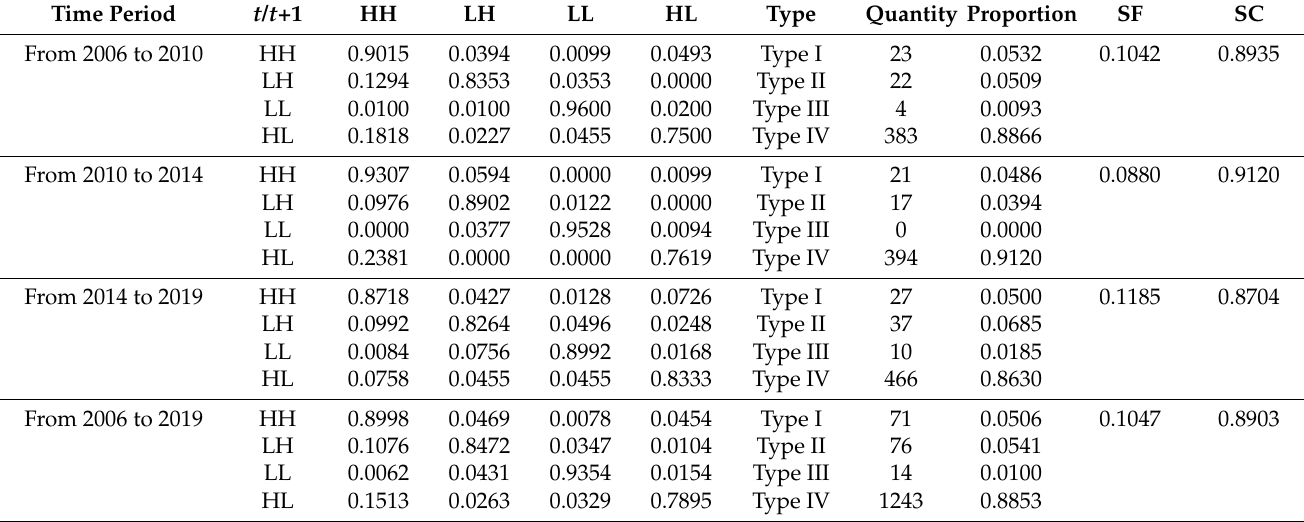
Table 2. Local Moran’s I transition probability matrix of the coupling coordination between urbanisa- tion level and per capita carbon emissions in the Yangtze River Economic